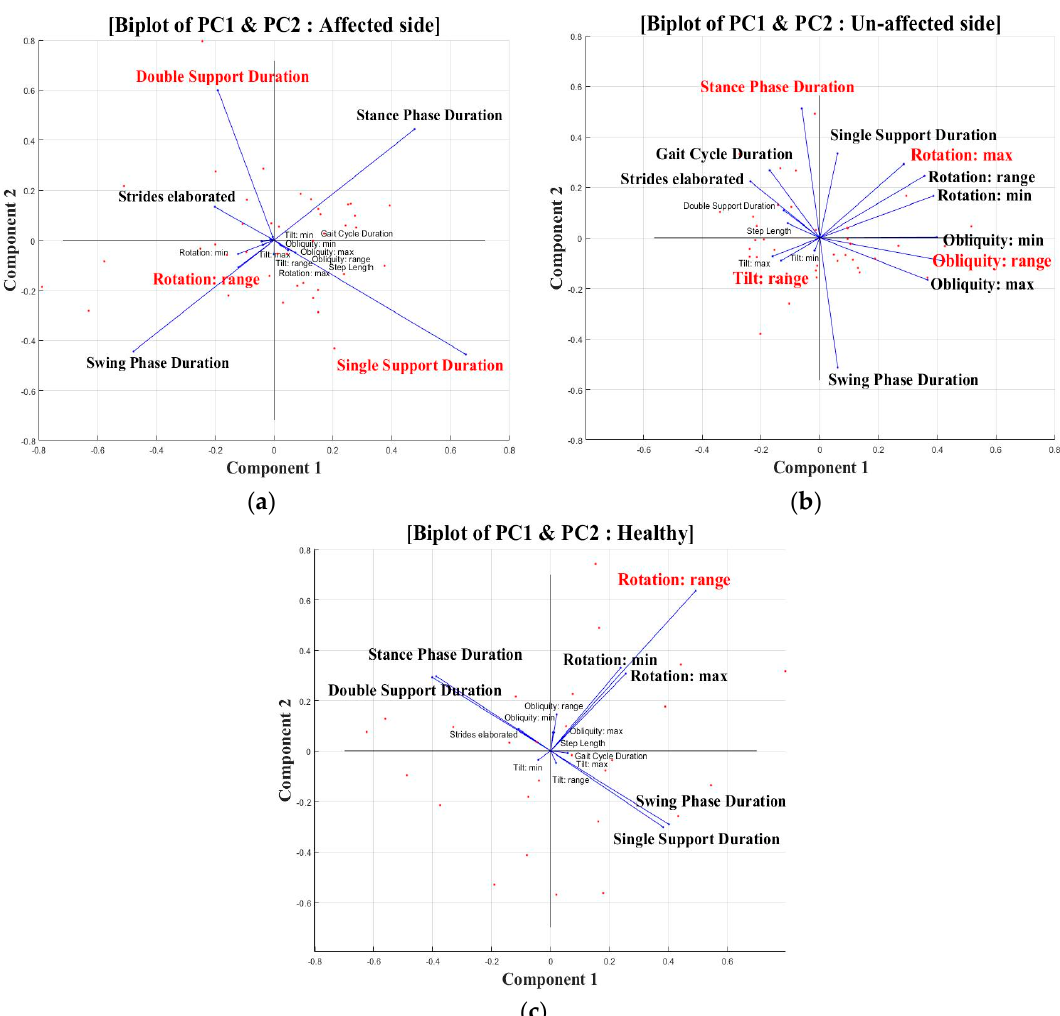
Figure 1. Biplots of selected features by PCs for ( a ) the affected side, ( b ) the unaffected side, and ( c ) healthy side. Table 3. Principal component analysis of each group.